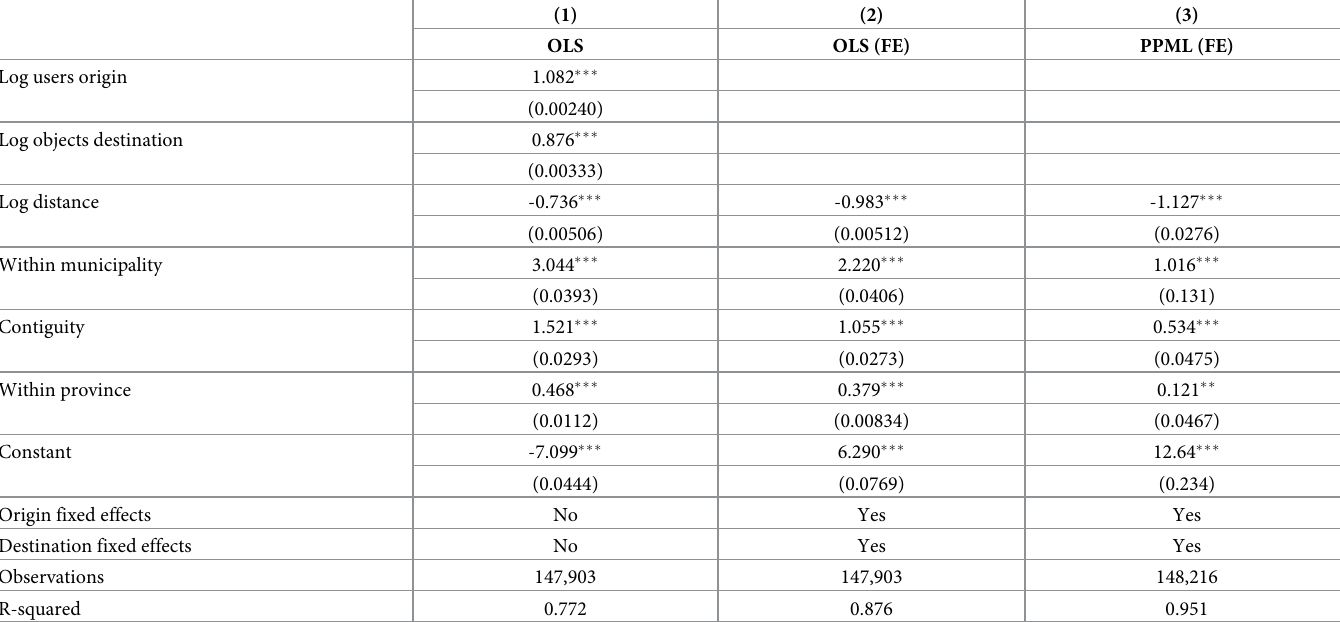
Table 2. Gravity model estimates of hit flows (full